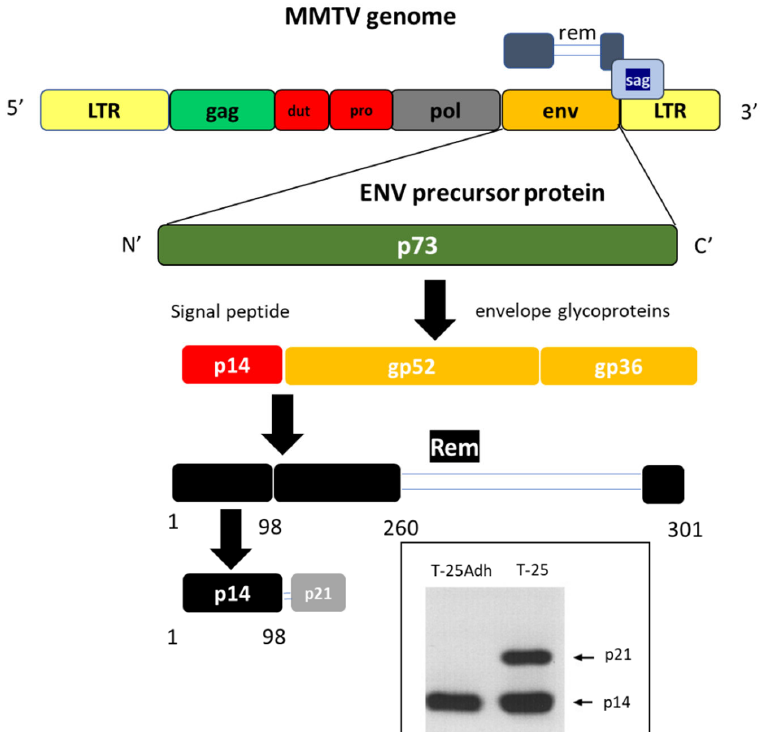
Figure 2. Protein products derived from the Env precursor protein of MMTV. p14 is the signal peptide. Rem and p21 are translation products of splice variants that include p14 with an extension into the envelope precursor sequence. Insert: Western blotting of T ‐ 25 and T ‐ 25 ‐ Adh cells with anti ‐ p14. p21 is specific to T ‐ 25 cells and their direct tumorigenic descendants. (see text for details). Rem—Regulator of export/expression of MMTV, sag—Superantigen.